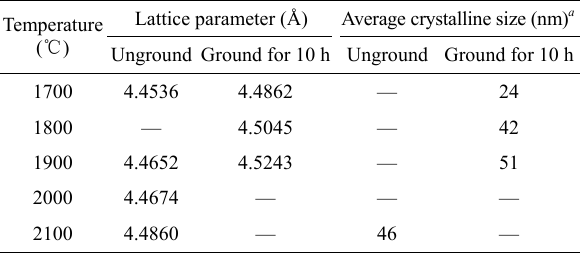
Table 1 Lattice parameters and average crystalline sizes of (HfZrTiNbTa)N powders synthesized from raw material mixtures unground and ground for 10 h